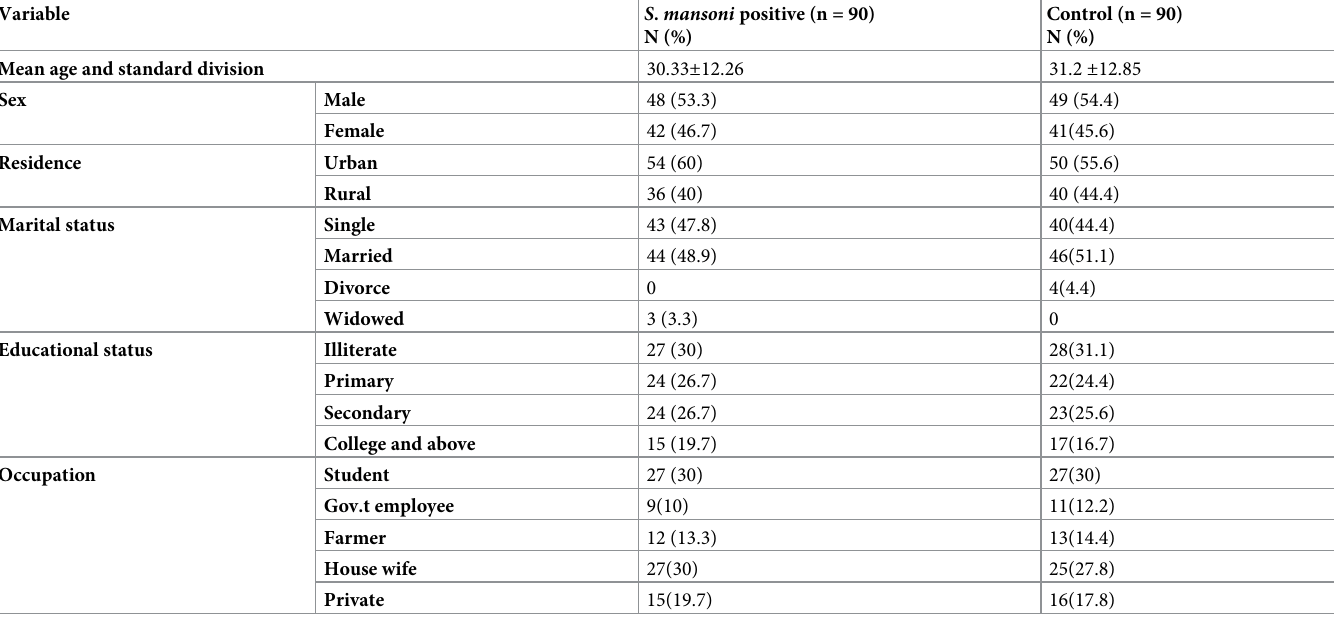
Control (n = 90) N (%) N (%)